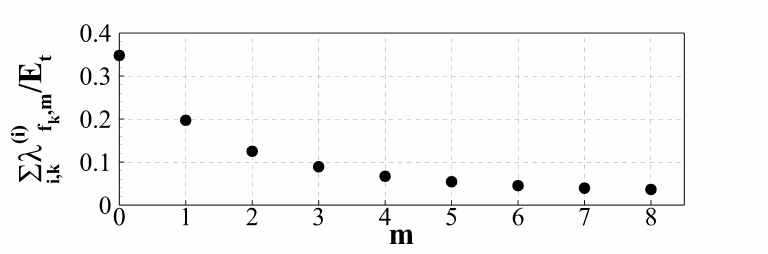
Figure 7. Azimuthal mode energy distribution.